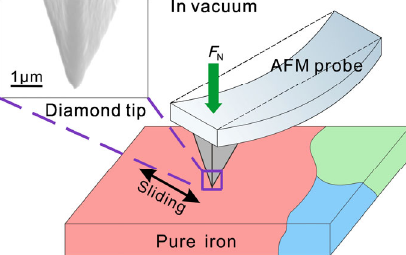
Fig. 1 Schematic of the nanoscale wear tests conducted within one crystalline grain of pure iron. The inset shows a scanning electron microscopy image of the cone-shaped diamond